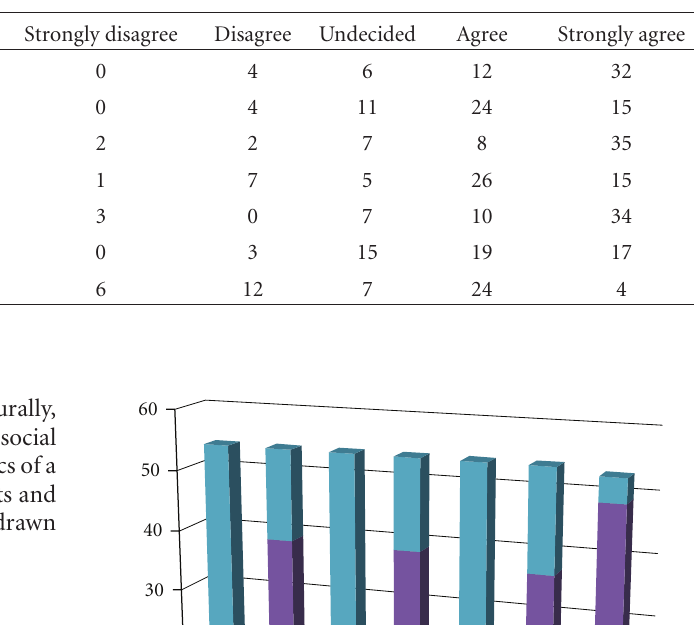
Table 2: System evaluation.